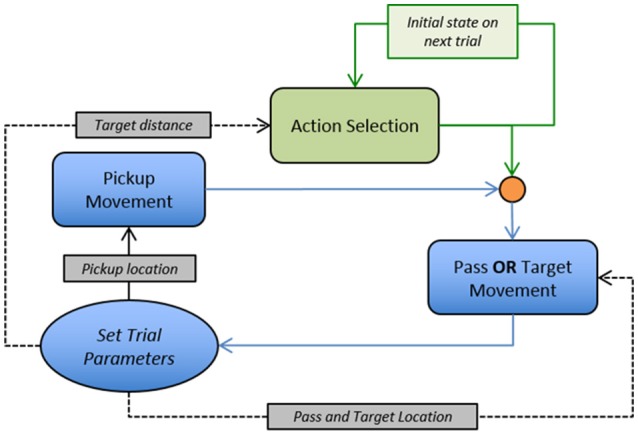
Flow diagram illustrating the implementation of the behavioral dynamics model for data simulations. Movement trajectory dynamics for the pickup, pass, and target movements defined by Equation (7). Action selection dynamics defined by Equation (8). Note, that the orange circle is a Heaviside function that defines the goal location as either the pass location or the target location depending on the output of the action selection dynamics.